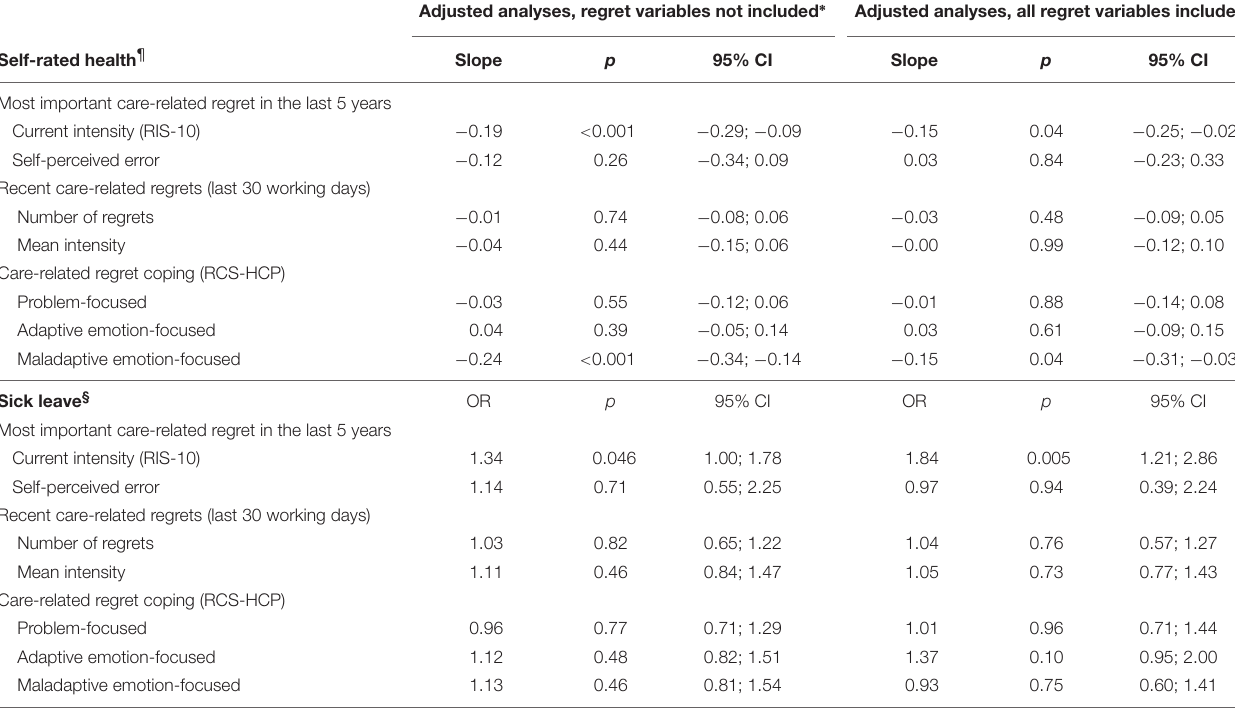
TABLE 2 | Association of care-related regret with health conditions among nurses. Adjusted analyses, regret variables not included